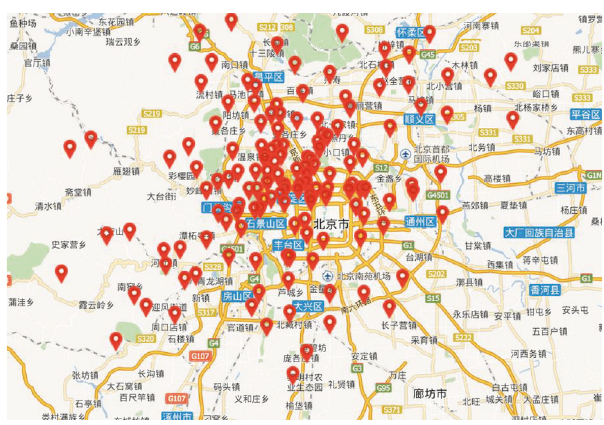
Figure 6: Customer